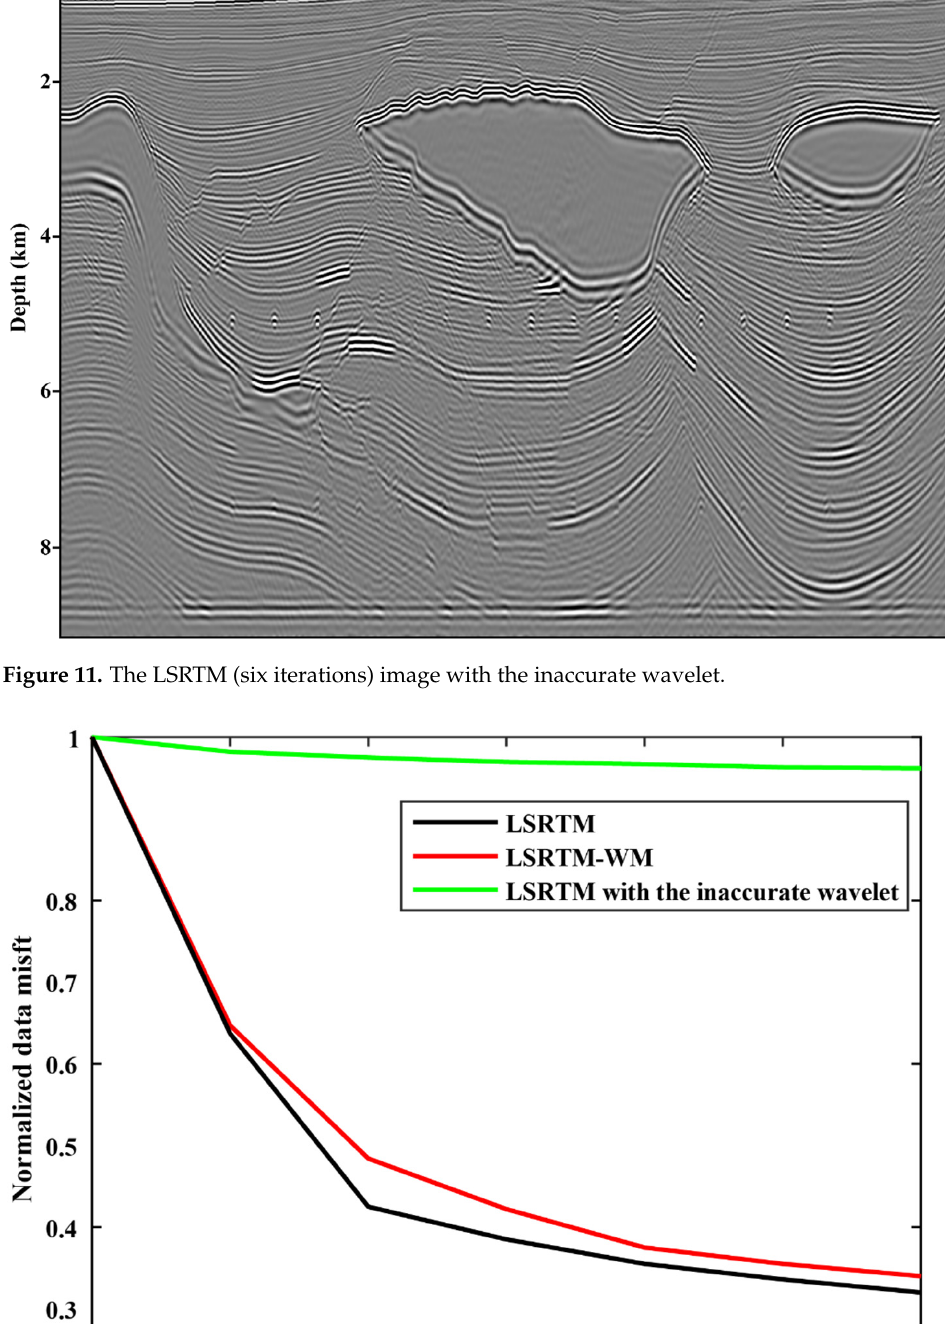
Figure 12. Convergence curves for LSRTM (Figure 9a), LSRTM-WM (Figure 10b), and LSRTM with the inaccurate wavelet (Figure 11) are indicated by the black, red, and green lines, respectively.